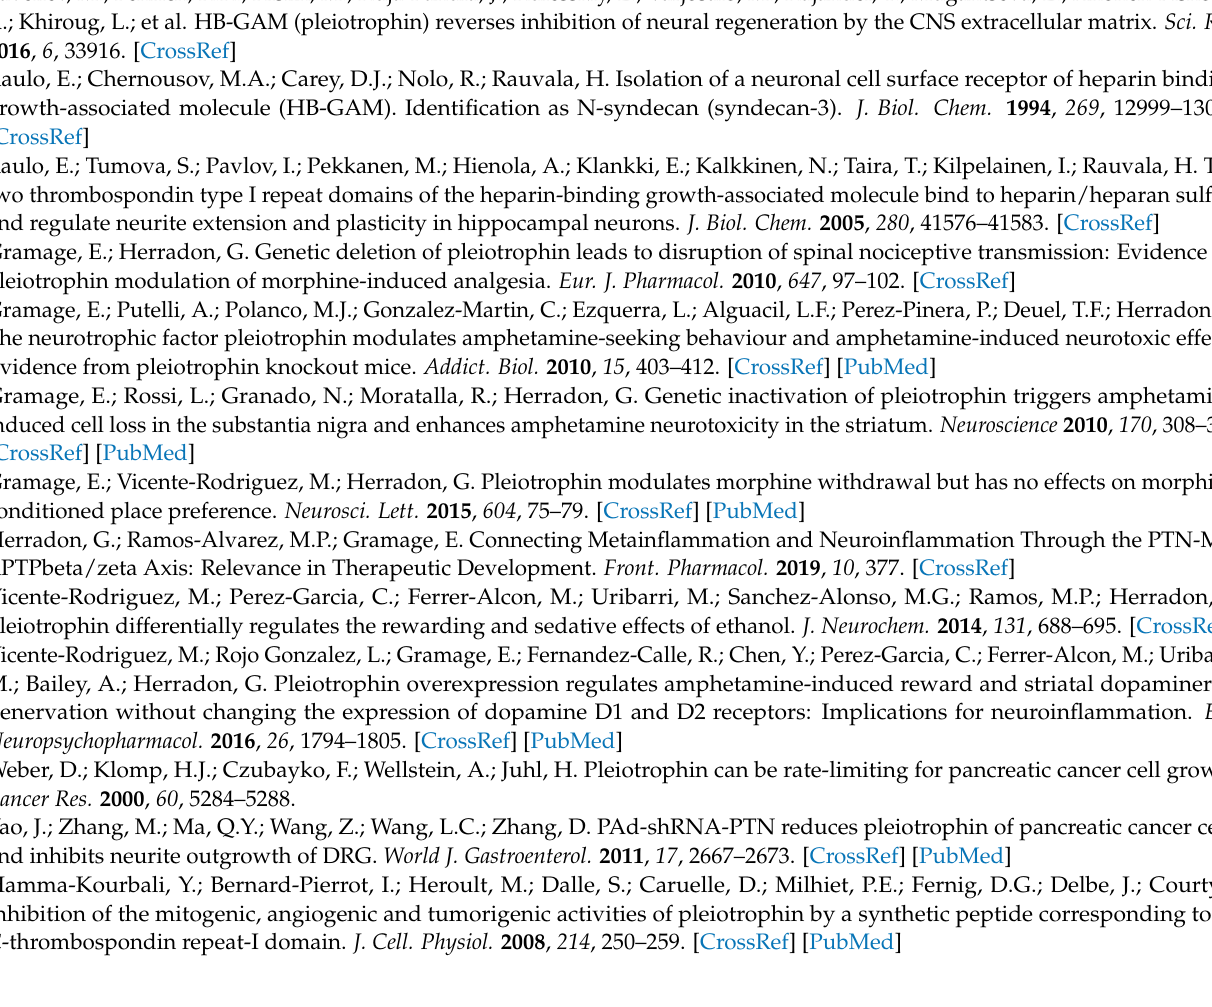
Figure S6: Titrations of PTN with unmodified or selectively desulfated heparin dp6, Figure S7: Inter- molecular distances in models of CTD and NTD bound to DP6-C, Table S1: Ambiguous constraints used to model the interactions of PTN domains with DP6-C, Table S2: Scores of the top 10% of the CTD-DP6-C models with the closest distance to IdoA2S.H2/ ∆ UA2S.H3, Table S3: Scores of the top 10% of the NTD-DP6-C models with the closest distance to IdoA2S.H2/ ∆ UA2S.H3, Table S4: Complete assignment of lysine side chains of PTN with DP6-C, File S1: PDB coordinates of the models of CTD and NTD bound to